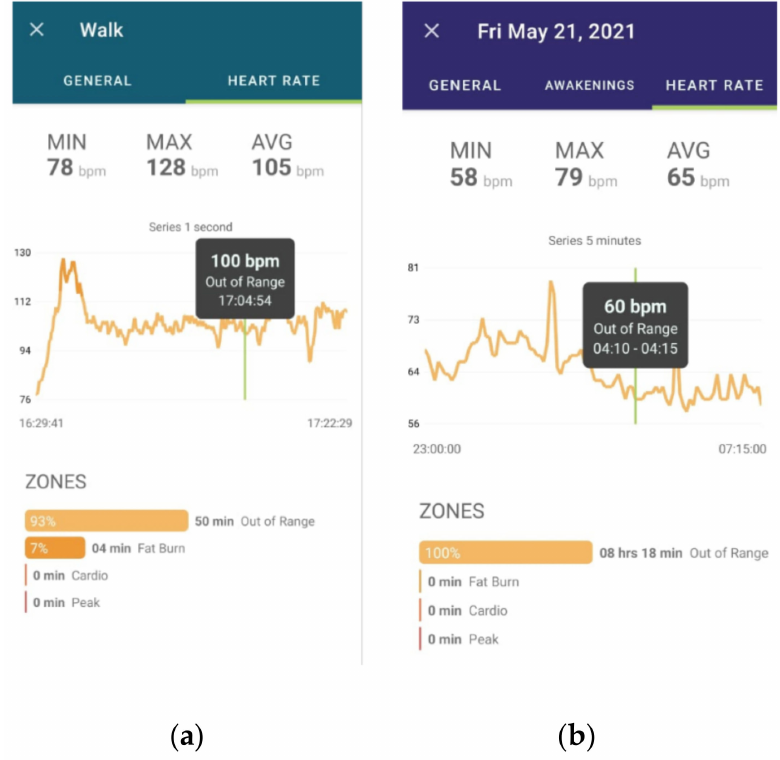
Figure 1. Overview of the SMH mobile app. ( a ) is a walk screen and ( b ) is a sleep screen.